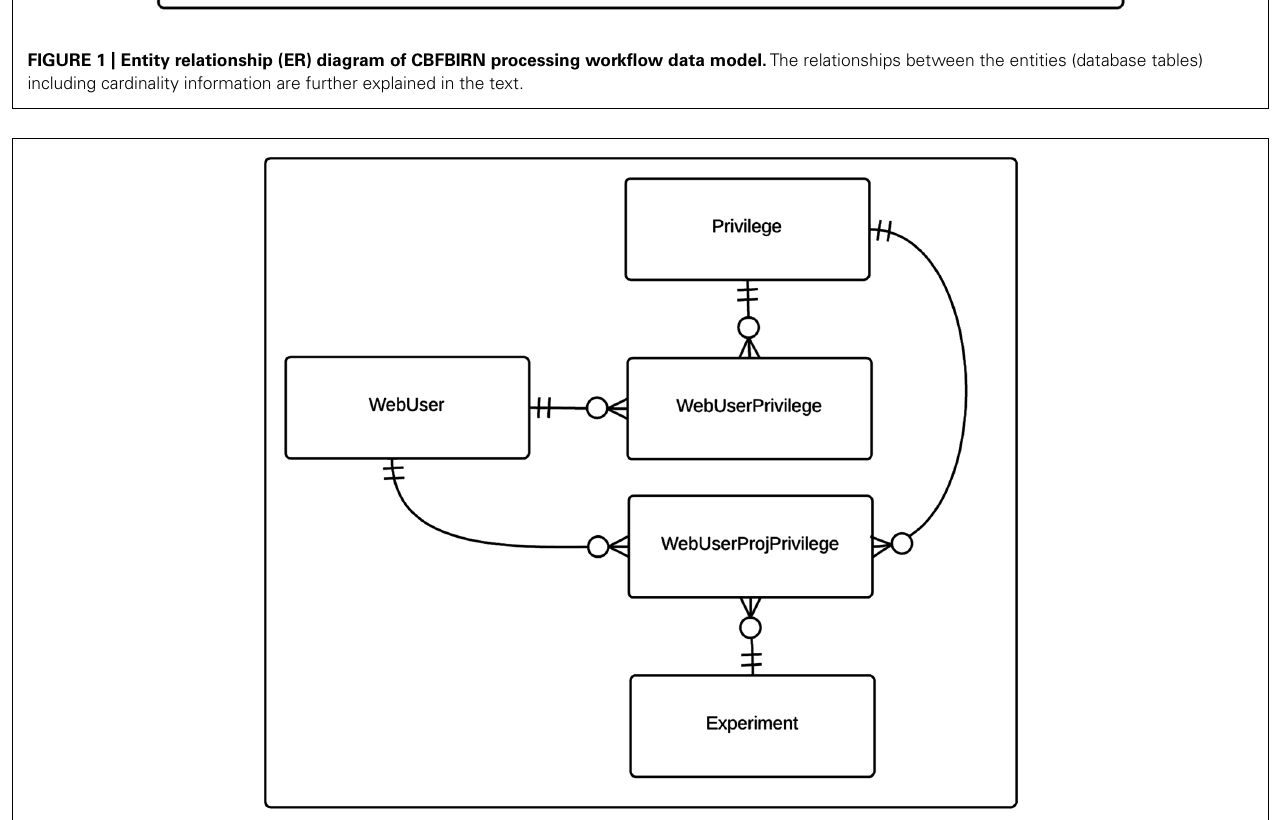
FIGURE 2 | Entity relationship (ER) diagram of CBFBIRN privilege-based security data model. The relationships between the entities (database tables) including cardinality information are further explained in the text.